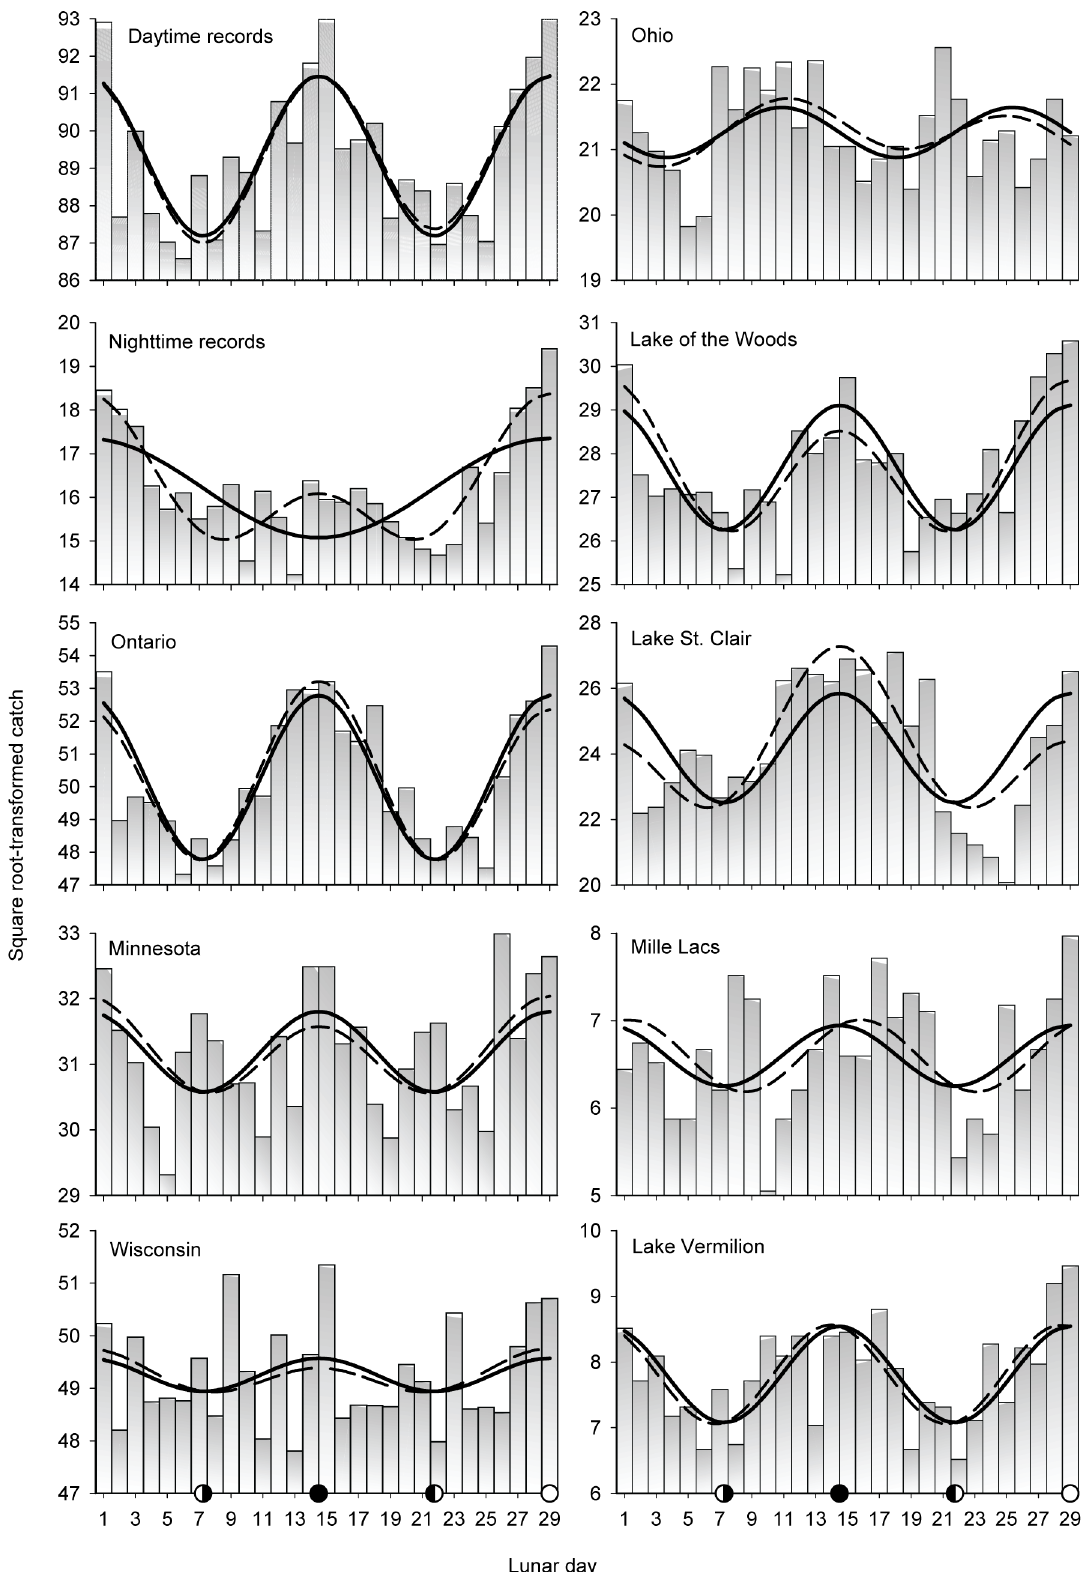
Figure 3. Periodic regression results for catch records. Bars are transformed counts. Solid regression lines are for the best single-predictor regression model. Dashed lines are for the best two-predictor model. Regression statistics given in Table 1.